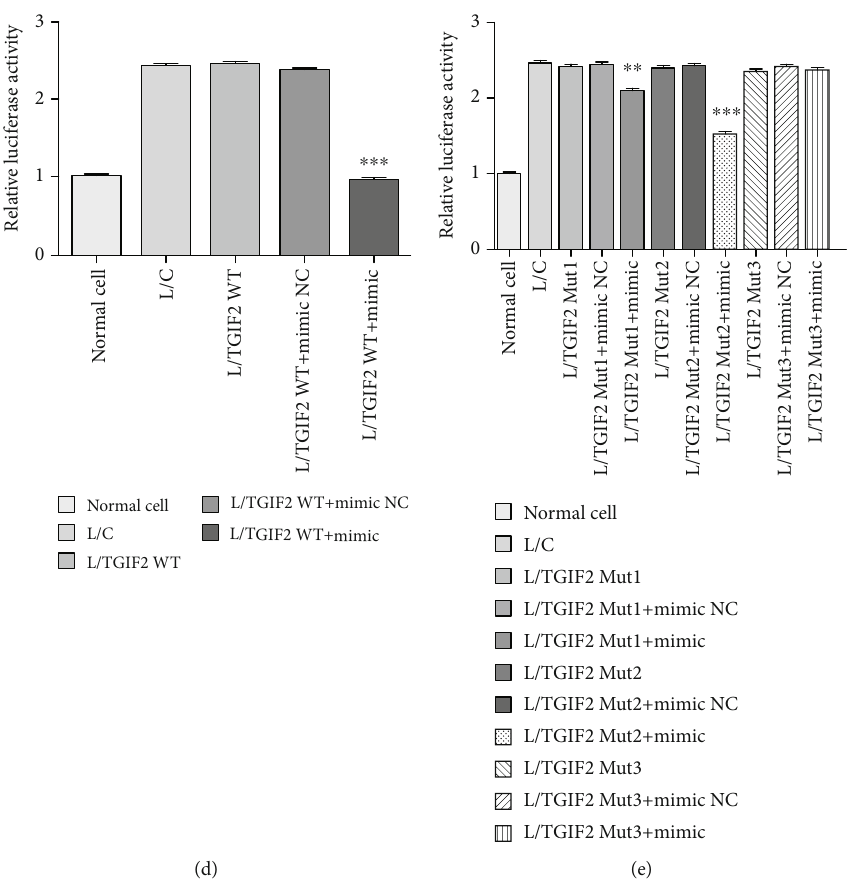
Figure 1: TGIF2 was the target gene of miR-34a. (a) The predicted two binding sequence of miR-34a on 3 ′ -UTR of TGIF2 and their mutations. (b) TGIF2 mRNA level (miR-34a mimics vs. NC, P < 0 : 0001 ∗∗∗ ; miR-34a mimics vs. inhibitor, P < 0 : 0001 ∗∗∗ ; and miR-34a inhibitor vs. NC, P < 0 : 0001 ∗∗∗ ). (c) Relative TGIF2 protein expression (miR-34a mimics vs. NC, P = 0 : 0334 ∗ ; miR-34a mimics vs. inhibitor, P = 0 : 0015 ∗∗ ; and miR-34a inhibitor vs. NC, P = 0 : 0184 ∗ ). (d) Relative luciferase activity of wild-type TGIF2 (L/TGIF2 WT +mimics vs. L/TGIF2 WT+NC, P < 0 : 0001 ∗∗∗ and L/TGIF2 WT+mimics vs. L/TGIF2 WT, P < 0 : 0001 ∗∗∗ ). (e) Relative luciferase activity of three types mutations of TGIF2 (L/TGIF2 mut1+mimics vs. L/TGIF2 mut1+NC, P = 0 : 0026 ∗∗ ; L/TGIF2 mut2+mimics vs. L/TGIF2 mut2+NC, P < 0 : 0001 ∗∗∗ ; and L/TGIF2 mut3+mimics vs. L/TGIF2 mut3+NC,